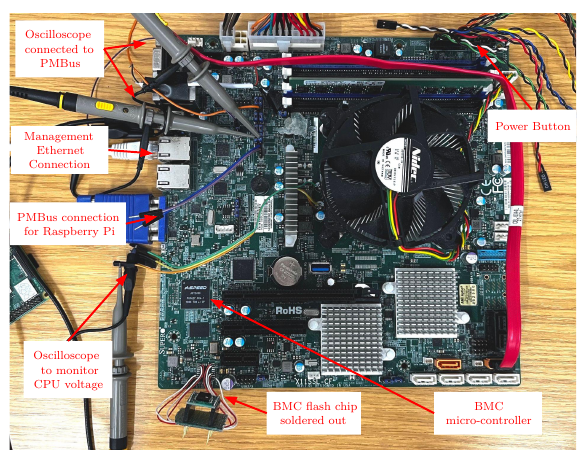
Figure 5: Setup of the E3-1220V6-X11SSL-CF for practical experiments. These connections are for experiments only; physical access is not required in the actual